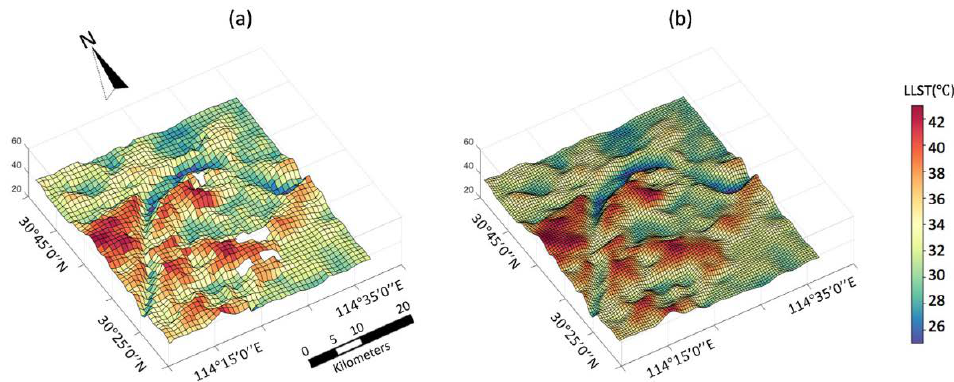
Figure 5. The Latent Pattern of LST (LLST) of 28 July 2014 generated by the Multi-Task Gaussian Process Modeling (MTGP). ( a ) The original image; ( b ) the LLST.